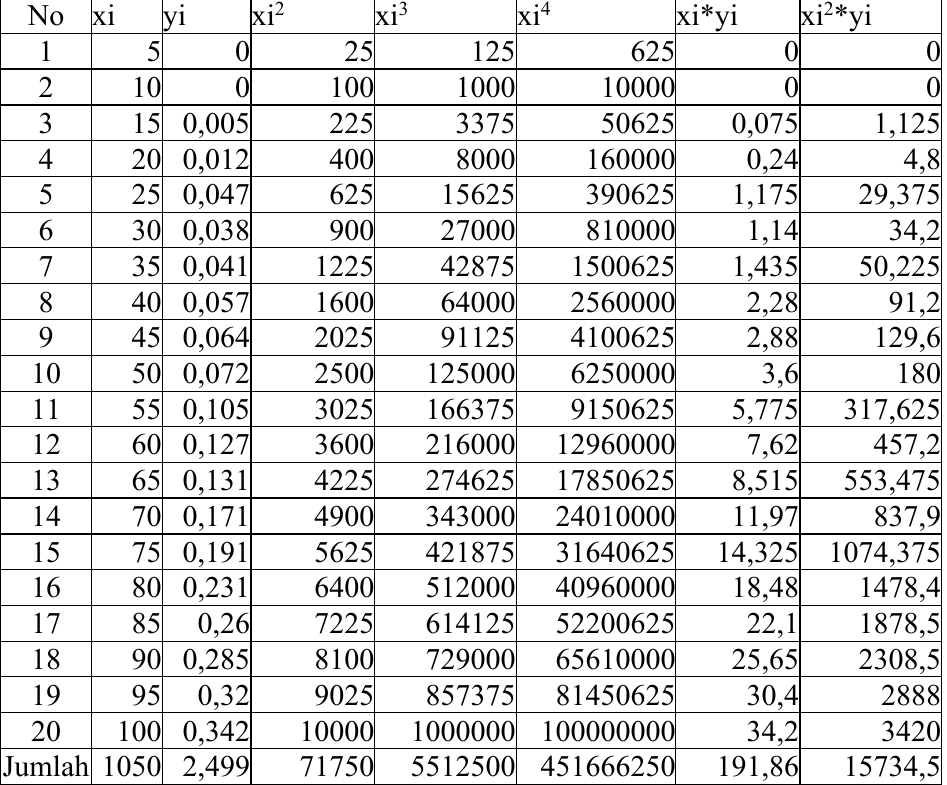
Table 4. Data for finding curve equations in experiment